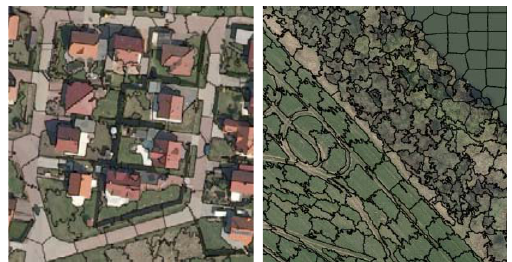
Figure 3: Extracted SLIC superpixels, each of size 50 x 50 pixels, superimposed to an orthophoto of an urban scene (left) and a rural scene (right). The compactness is set to 20 in a range of